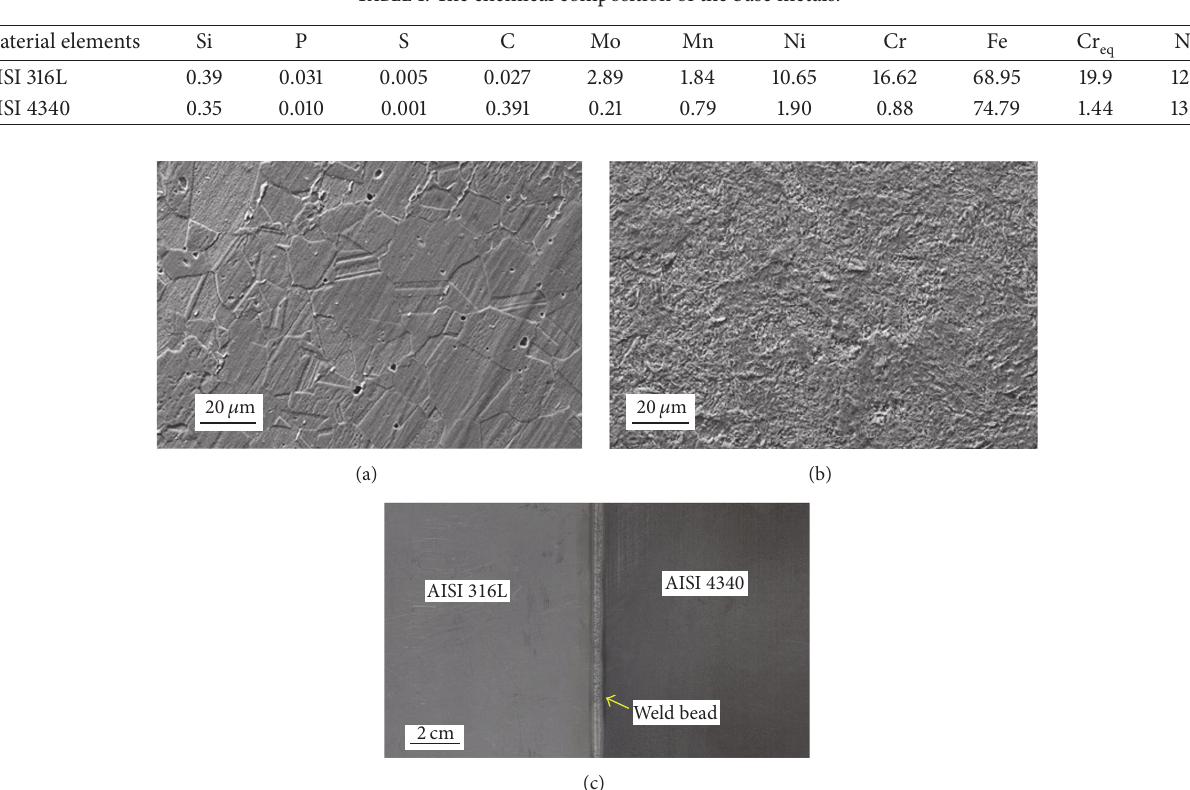
Figure 1: (a) Microstructures of AISI 316L. (b) Microstructures of AISI 4340 steel. (c) The welded joint macrograph.